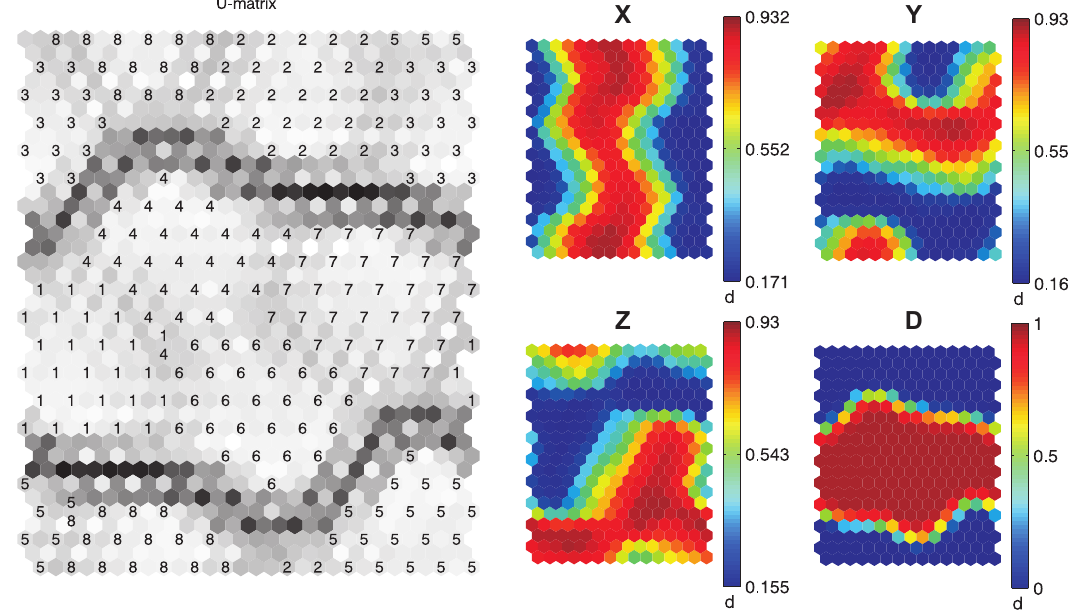
Fig. 3. U-matrix (left) and component planes (right) of the standard SOM-analysis of the theoretical data set.